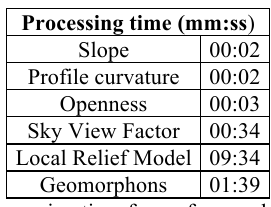
Table 3. Processing time for surface analysis